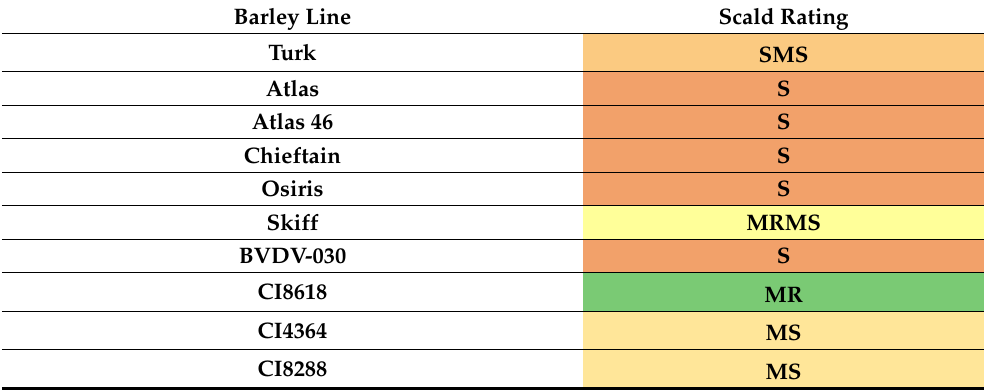
Table 3. Pathotype results of isolate 1972 collected in a barley crop near Rochester, Victoria in 2020. Barley